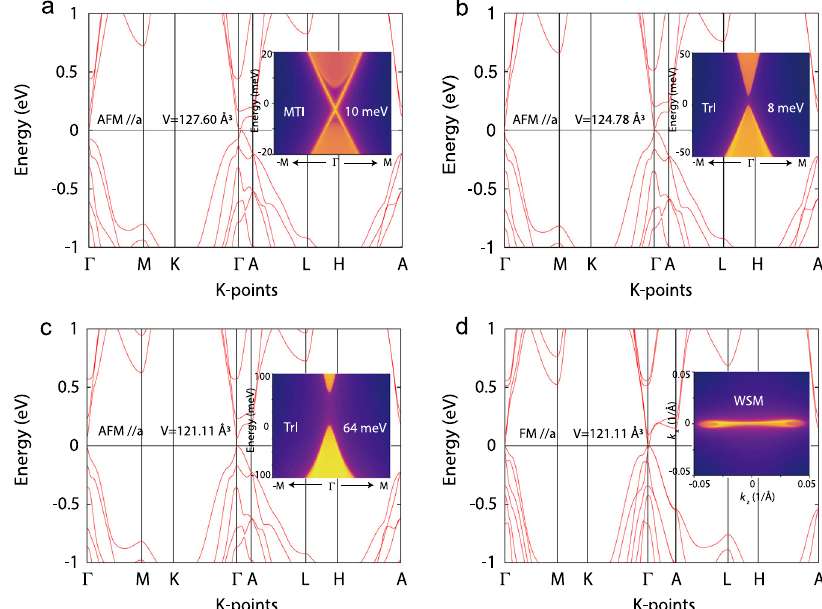
Fig. 4 Calculated band structures of EuCd 2 As 2 tuned by the magnetic ground state and pressure. The electronic structure of A-type AFM EuCd 2 As 2 with moments in the ab -plane, for unit cell volumes of ( a ) 127.60 Å 3 , ( b ) 124.78 Å 3 , and ( c ) 121.11 Å 3 . d The electronic structure for FM EuCd 2 As 2 with moments in the ab -plane, with a unit cell volume of 121.11 Å 3 . Depending on the magnetic ground state and pressure (unit cell volume), EuCd 2 As 2 may be a magnetic topological insulator (MTI), a trivial insulator (TrI), or a Weyl semimetal (WSM). The values of the energy gaps for the MTI and TrI states are indicated in the insets of ( a – c ). The insets in ( a – c ) show calculated surface states along − M Γ M , with clear topologically-protected surface states in ( a ). The inset in ( d ) shows the surface Fermi arc along k z in the k x − k z